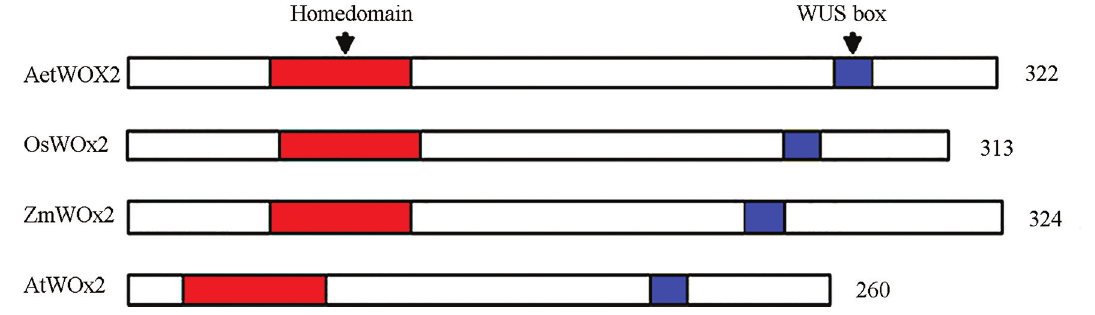
Figure 1 - Structure of WOX2 proteins in different species. Abbreviations are Ae. tauschii , Aet; O. sativa , Os; Z. mays , Zm; A. thaliana , At; The homeodomain (red) is the most prominent and defining feature of the family. The WUS-box motif (blue) was defined in a strict sense, as T-L-[DEQP]-L-F-P-[GITVL]-[GSKNTCV], consensus